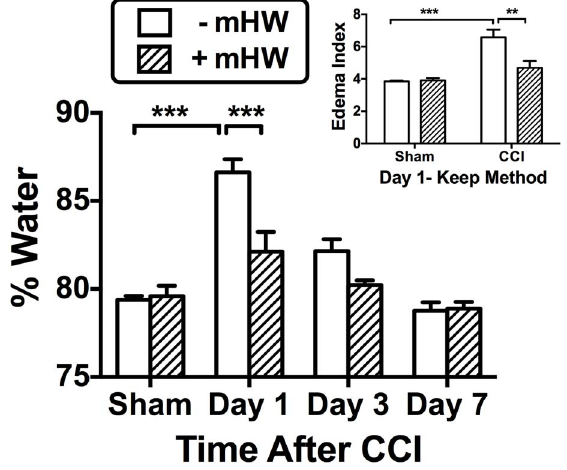
Figure 1. Effects of CCI and mHW on Brain Edema. Main figure shows that the percent of brain weight that was water increased 24 h (day 1) after CCI and that mHW significantly reduced the water content. Inset shows brain edema index calculated by the Keep method at 24 h; CCI increased the edema index, while mHW was protective. **p , 0.01, ***p ,